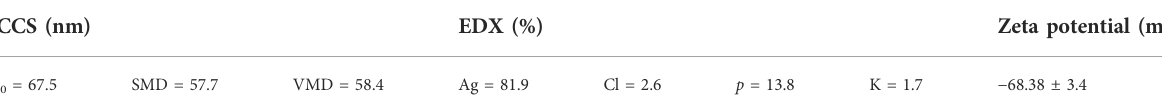
TABLE 2 PCCS, EDX, and Zeta potential